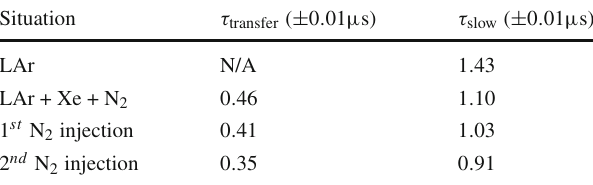
Table 10 Time constants obtained from the fit of the average wave- forms at the different doping concentrations. Errors show the variation among PMTs